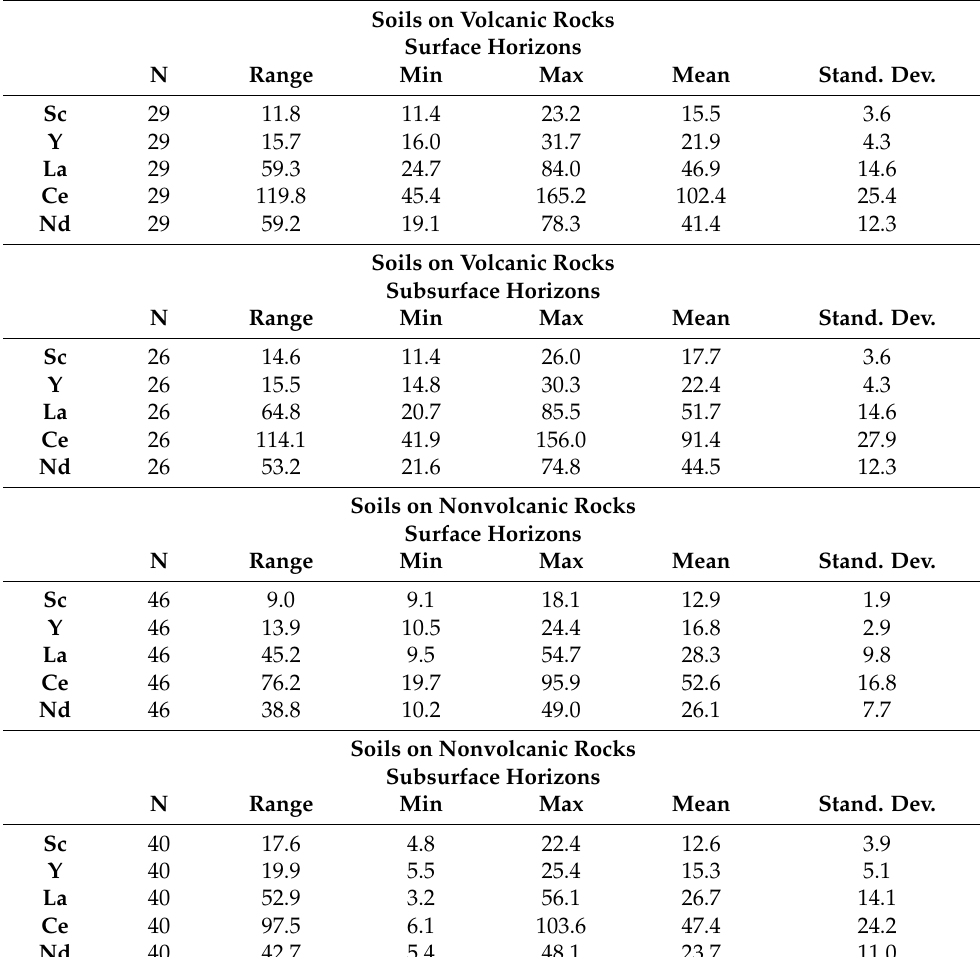
Table 3. Descriptive statistical data for rare earth elements separated between soils on volcanic rocks and soils on nonvolcanic rocks in Campo de